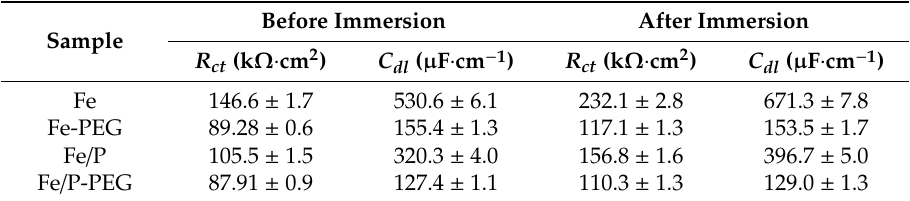
Table 5. Impedance parameters of iron-based foams (Fe, Fe-PEG, Fe / P, and Fe / P-PEG) in Hanks’ solution before and after 1-h